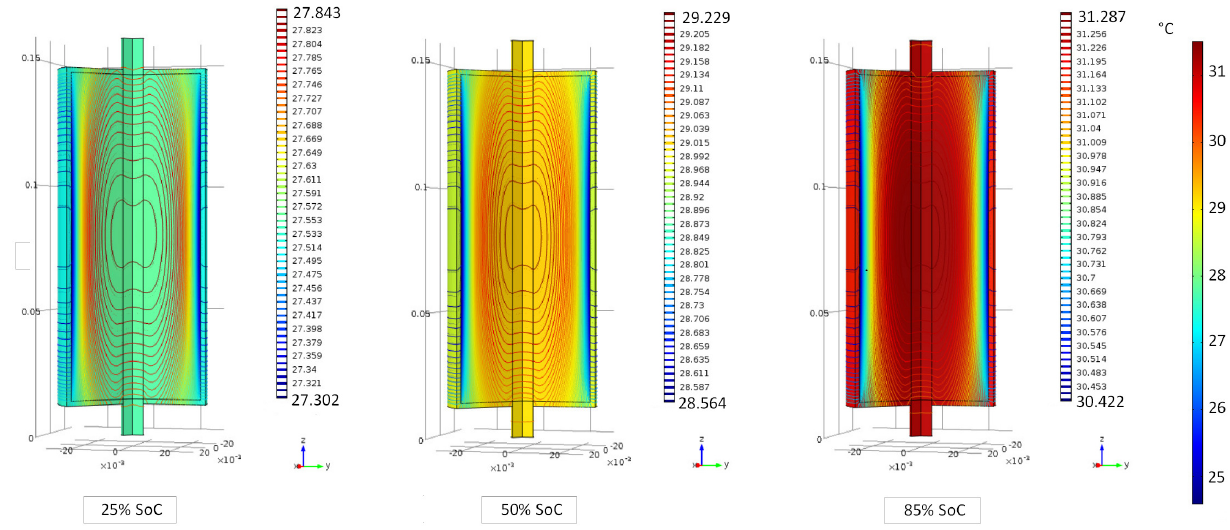
Figure 10. Temperature distributions during a 3 I internal region.